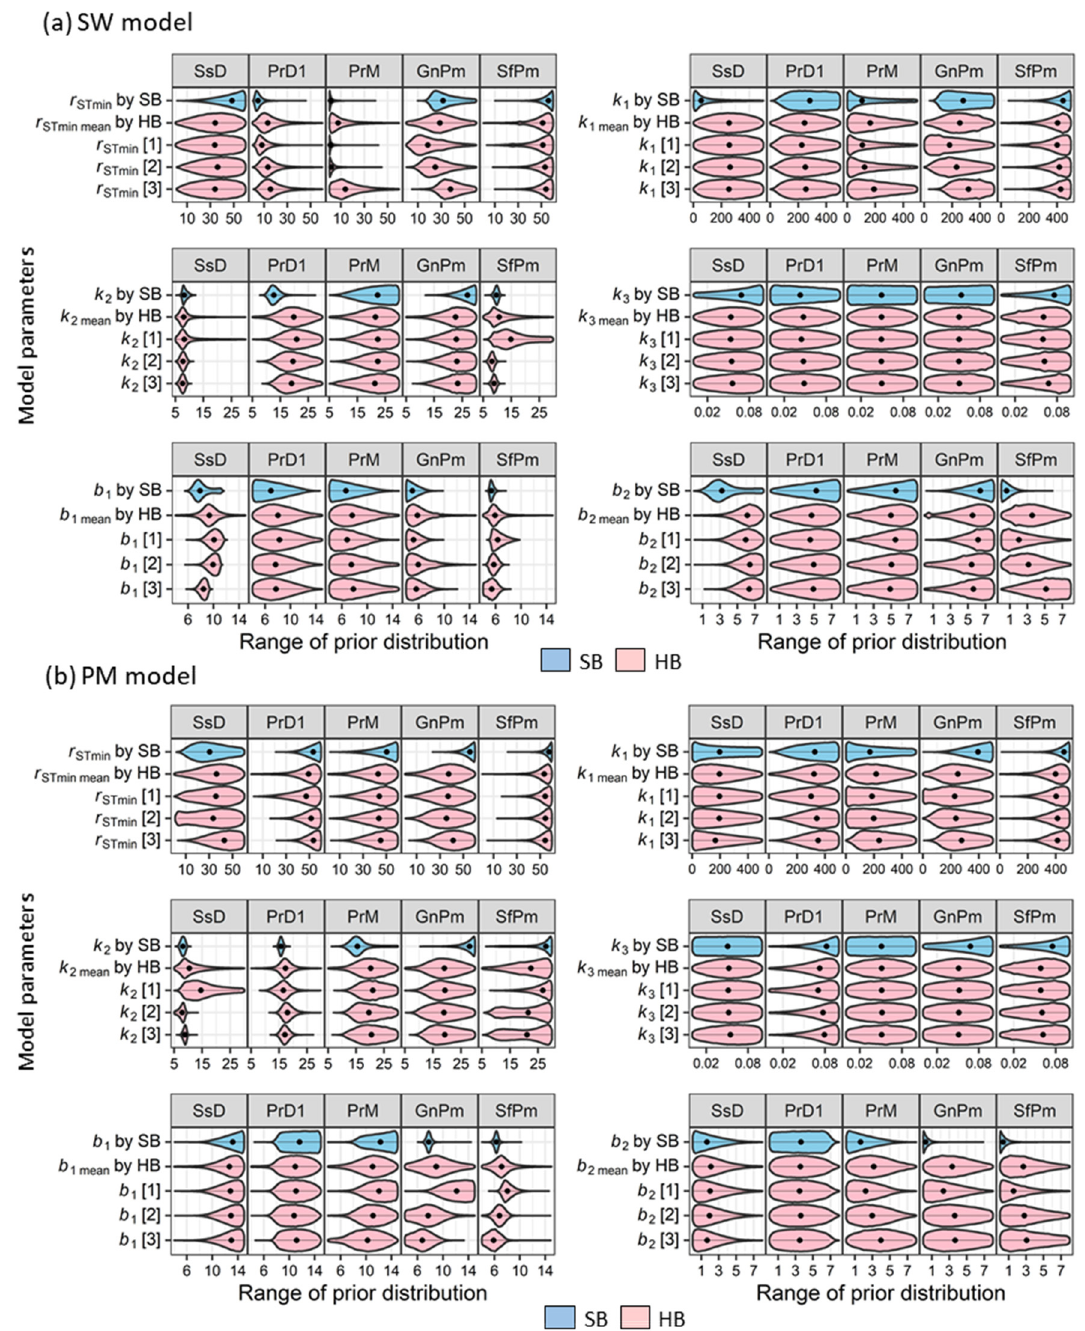
Figure 3. Violin plots of the posterior distributions of ( a ) the Shuttleworth–Wallace (SW) and ( b ) the Penman–Monteith (PM) model parameters calibrated using simple Bayesian (SB) and hierarchical Bayesian (HB) approaches. The numbers in square brackets with parameters indicate the three calibration periods of the HB approach. Parameters with mean by HB represent the overall mean distribution. The black dotted circles and horizontal lines inside the violin shapes represent the posterior means and 95% confidence intervals.